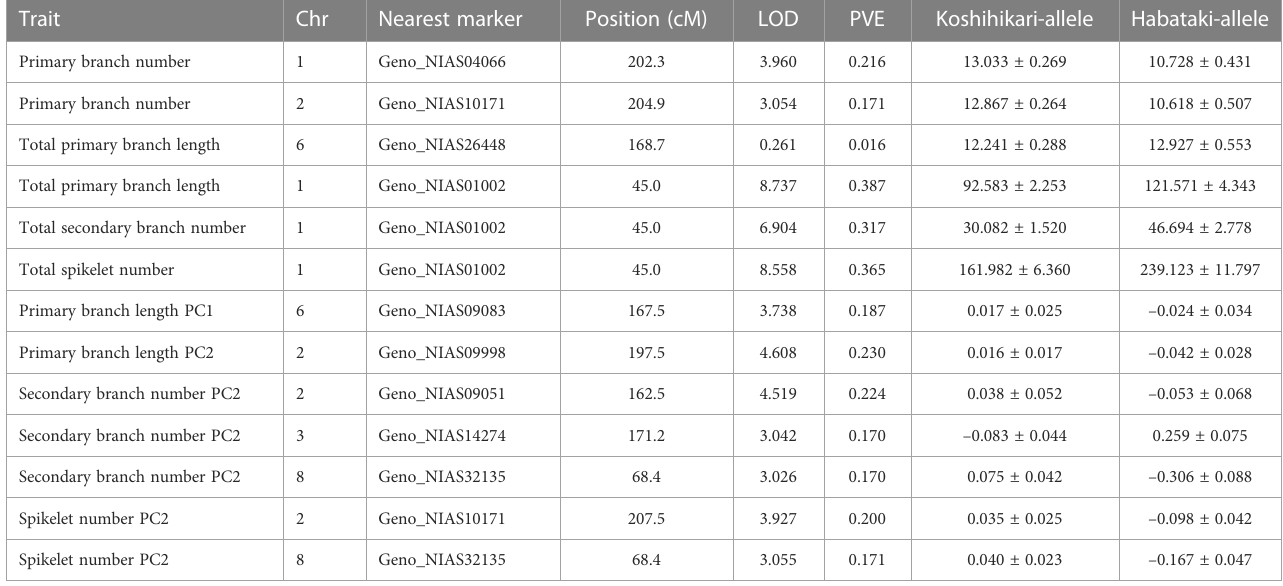
TABLE 3 Estimated effects of quantitative trait loci